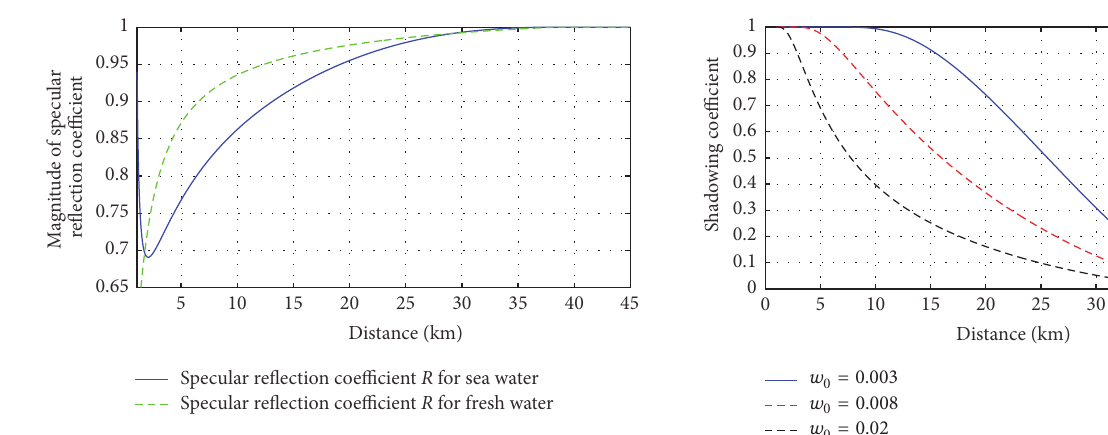
Figure 17: 𝑅 as a function of the TX-RX distance ( ℎ = 3.4 m). ℎ RX